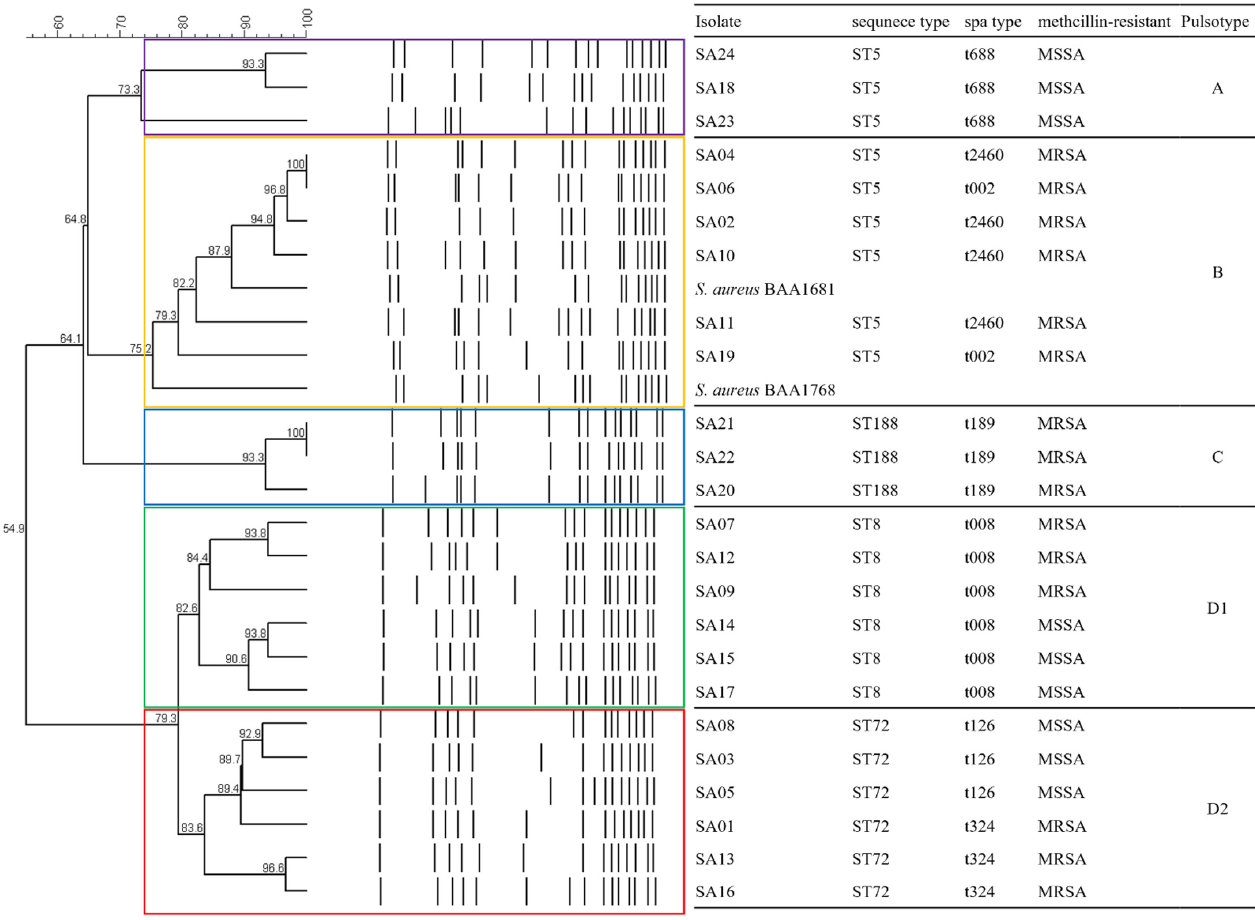
Figure 3. Characteristic of 24 S. aureus isolates with dendrogram of PFGE analyses. Purple, yellow, blue, green, and red box mean each clustering pulsotypes.